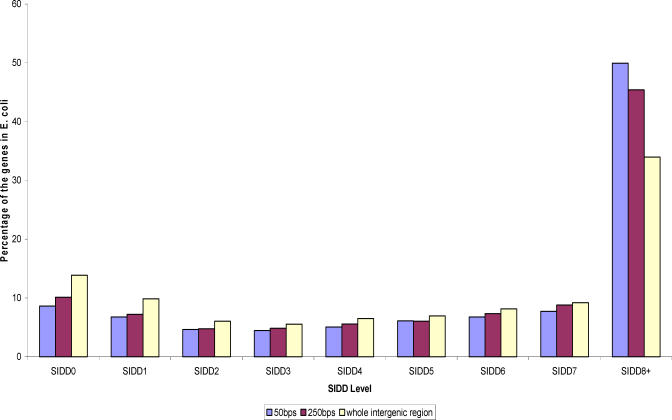
Genes in the E. coli K12 Genome according to Their Upstream SIDD SitesThe genes in the E. coli K12 genome are grouped according to the most destabilized SIDD sites in their whole upstream regions (yellow columns), or the most destabilized SIDD site in their immediate 50-bp or 250-bp upstream regions (blue or red columns), respectively. The former classification shows the highest SIDD0 fraction because there are fewer of them; 3,656 genes have 5′ intergenic flanks, while all 4,518 genes in the May 2006 release of GenProtEC are included in the other cases.